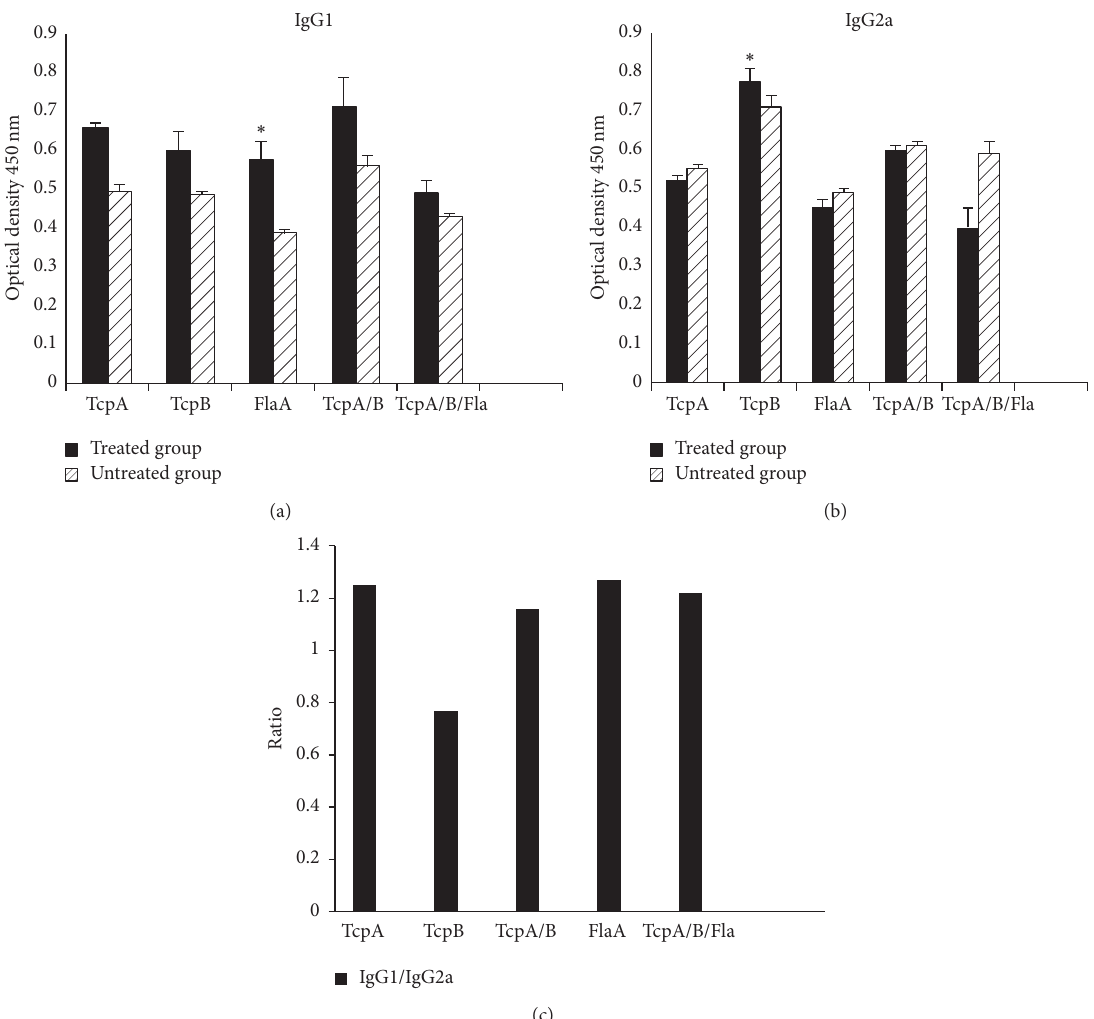
Figure 5: Measuring IgG1 (a) and IgG2a (b) and IgG1/IgG2a (c) antibodies in the vaccinated mice using ELISA method three weeks after immunization. Significant differences were designated as ∗ 𝑃 < 0.05